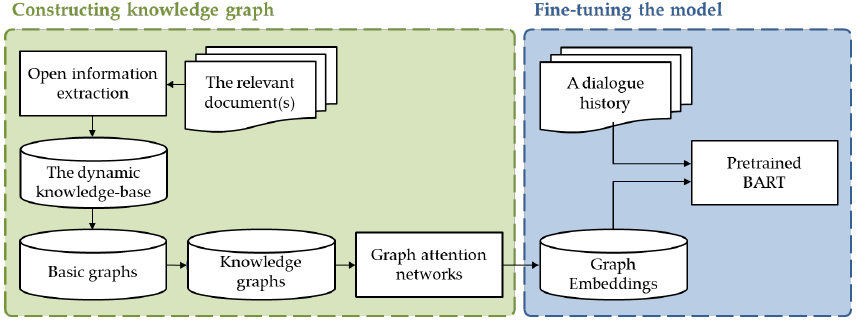
Figure 4. The overall workflow of the proposed